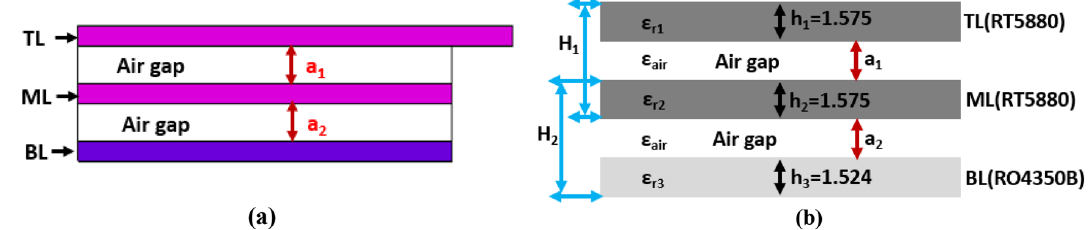
Figure 5. Air gaps optimization analysis: ( a ) Side view of simulated structure of the proposed antenna; ( b ) Side layout of the proposed